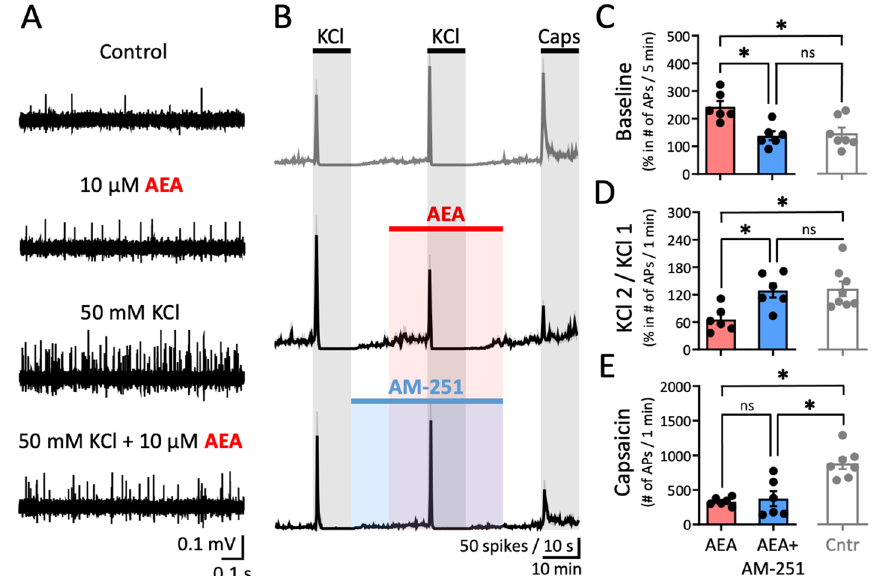
Fig. 6 Strong reduction of general meningeal excitability by exogenous AEA. A Example traces of APs recorded from the peripheral part of trigeminal nerve innervating rat meninges for the control condition i.e. before any application, during application of 10 µM AEA, within the 1‑min active phase of the 1 st KCl pulse and within the 1‑min active phase of the 2 nd KCl pulse when also 10 µM AEA was present. Note the increased nociceptive firing during 10 µM AEA application that decreased during the combined application with KCl. B Time courses of spike frequency (10‑s bin size) induced by two subsequent KCl pulses of 50 mM KCl and 1 µM Capsaicin in the control condition (data representation from Fig. 4B), within the combined application of 10 µM AEA with the 2 nd KCl pulse, and in the presence of CB1 antagonist AM‑251 (1 µM). C The ratio before and during the first 5‑min of the AEA application ( N 6) was lower compared to the corresponding windows ratio in the control condition (Cntr, N 7, data = = representation from Fig. 4B; Kruskal Wallis test, * 0.03) Combined application of AEA and AM‑251 counteracted the effect ( N 6, Kruskal Wallis = = test, * 0.02). D The ratio of KCl‑evoked APs (between the 2 nd and the 1 st (taken as 100%) KCl pulse) within the 1‑min active phase was strongly = decreased from the control (Cntr, N 8, data representation from Fig. 4C) condition when AEA was applied ( N 6, Kruskal Wallis test, * 0.02). = = = Application of also AM‑251 counteracted the effect ( N 6, Kruskal Wallis test, * 0.02). E The number of APs during the 1‑min active phase of 1 µM = = Capsaicin was reduced during the AEA application ( N 6, Kruskal Wallis test, * 0.01) and during the combined application of AEA and AM‑251 = = ( N 6, Kruskal Wallis test, * 0.01) compared to the control condition (Cntr , N 7; data representation from Fig. = = =